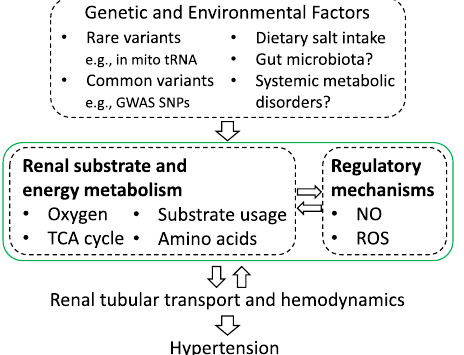
Fig. 3 The proposed overall mechanism by which renal energy and substrate metabolism contribute to the development of hypertension. It is well-established that genetic and environmental factors in fl uence renal tubular transport and hemodynamics, which, in turn, contribute to the development of hypertension and cause changes in renal energy and substrate metabolism. Recent advances in human and animal model research indicate that renal energy and substrate metabolism may also in fl uence the development of hypertension, which may be mediated by novel effects of renal energy and substrate metabolism on regulatory substances including NO and ROS and subsequent effects on renal tubular transport and hemodynamics. Mito mitochondria, GWAS SNPs blood pressure-associated single-nucleotide polymorphisms identi fi ed by genome-wide association studies, TCA tricarboxylic acid, NO nitric oxide, ROS reactive oxygen